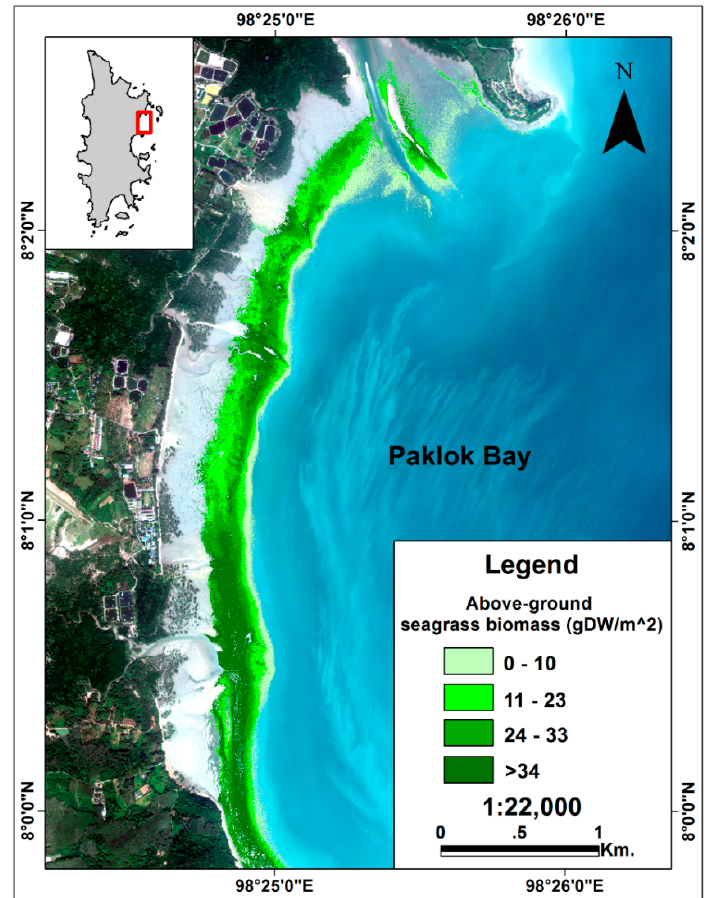
Figure 7. The above-ground seagrass biomass map for Paklok Bay derived from Worldview-2 image and field reference data.